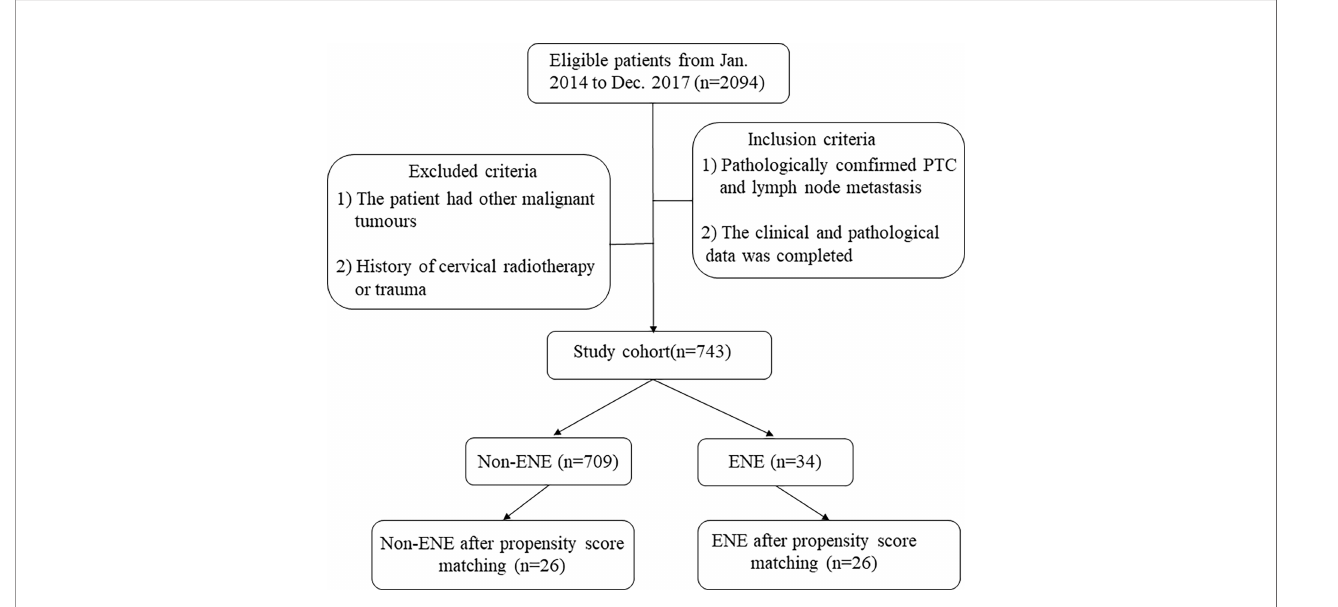
FIGURE 1 | Process of patient enrollment into the study cohort and included patients. ENE, extranodal extension; PTC, papillary thyroid